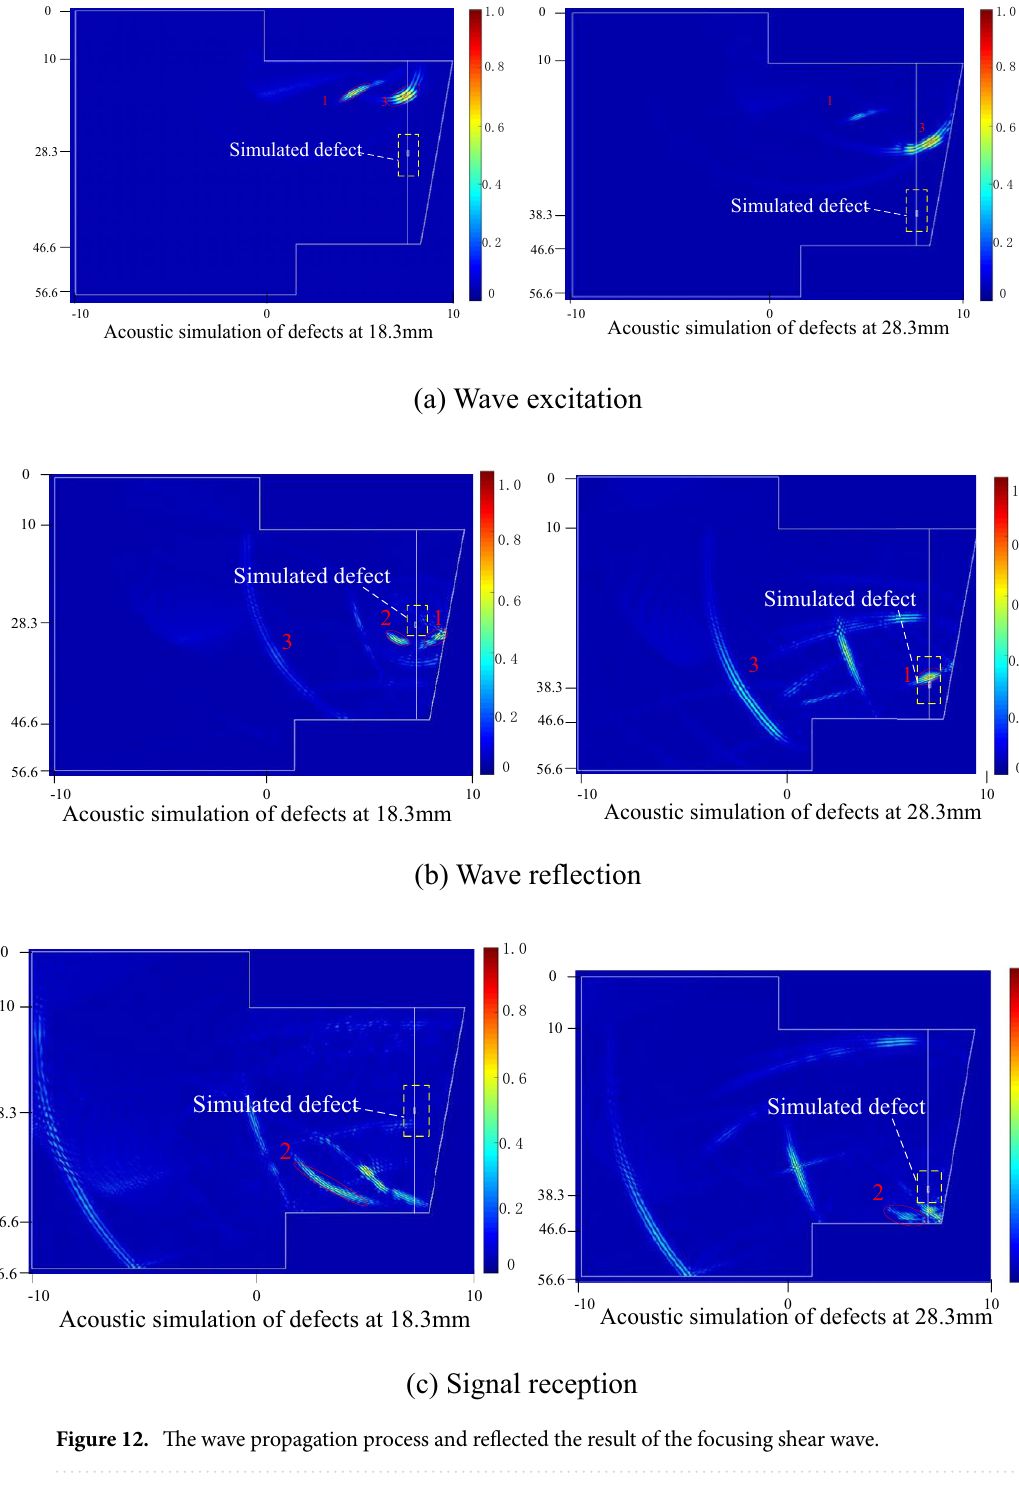
Figure 12. The wave propagation process and reflected the result of the focusing shear